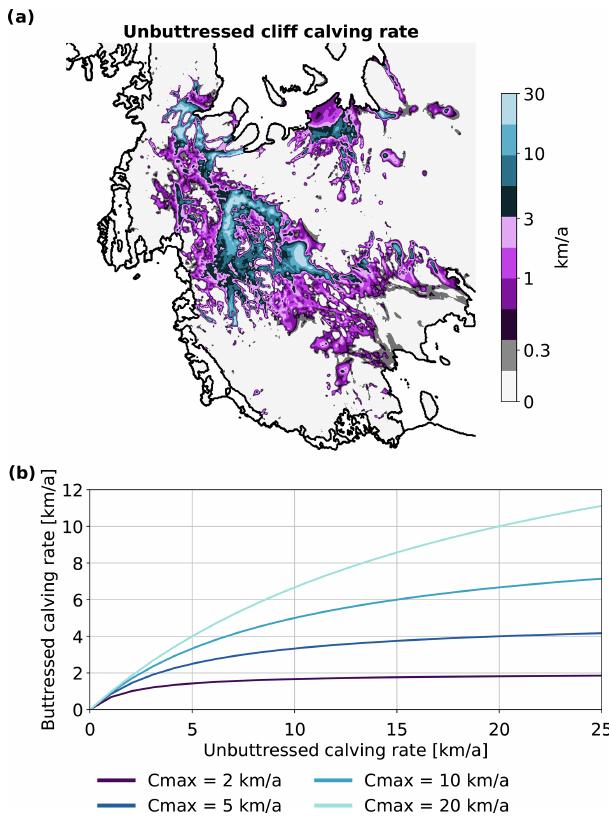
Figure 1. (a) Potential unbuttressed cliff-calving rates in the WAIS. For this estimate we assume the ice cliff to be at flotation thick- ness, making the calving rate a function of bed topography. In the case of very fast grounding-line retreat, the ice cliff may not have thinned to flotation and calving rates may be larger. (b) The mélange-buttressed calving rates as a function of the unbuttressed calving rates for the values of C max considered in this